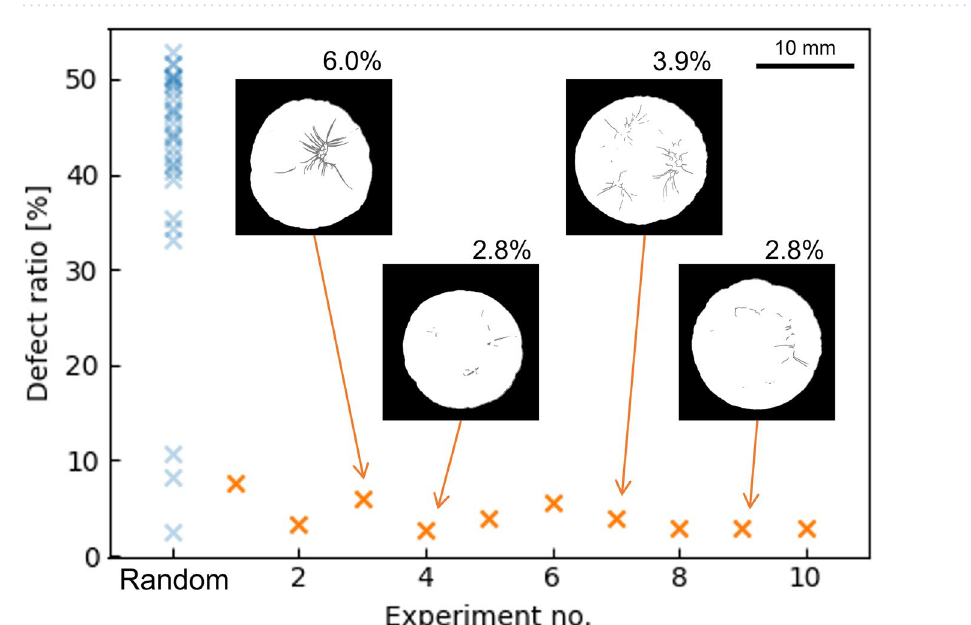
Figure 5. Comparison of the defect ratios observed in the exploration with the defect ratios in the initial data. The latter are shown in blue on the left side of the plot. The typical binarized appearances of the samples obtained in the exploration are shown in the